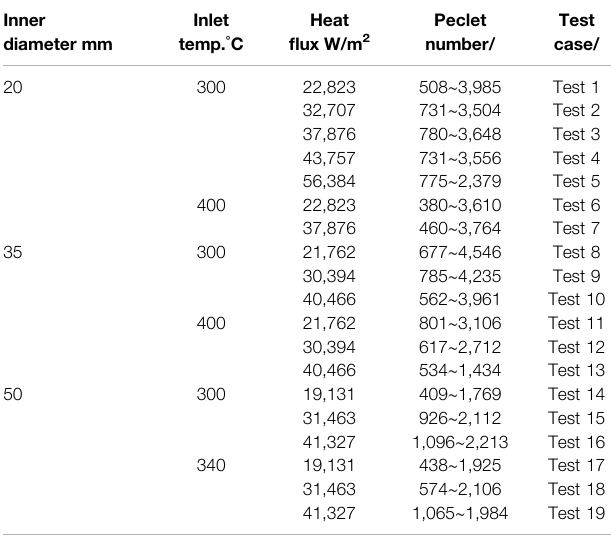
TABLE 1 | Experimental conditions for each